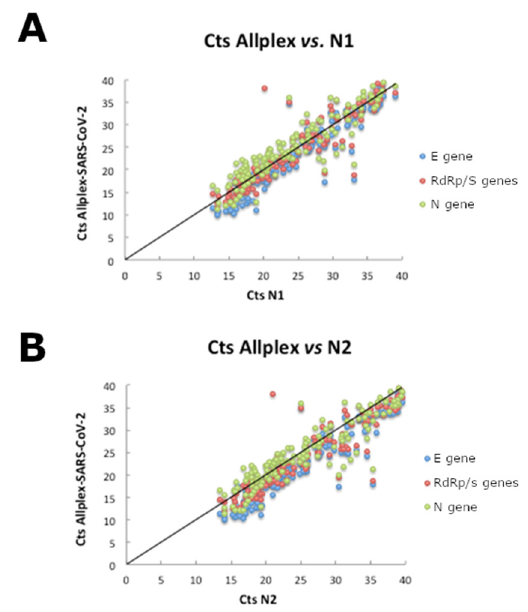
Figure 2. Correlation between Ct values in the CDC and Allplex tests for the N1 ( A ) and N2 ( B ) targets for the CDC assay